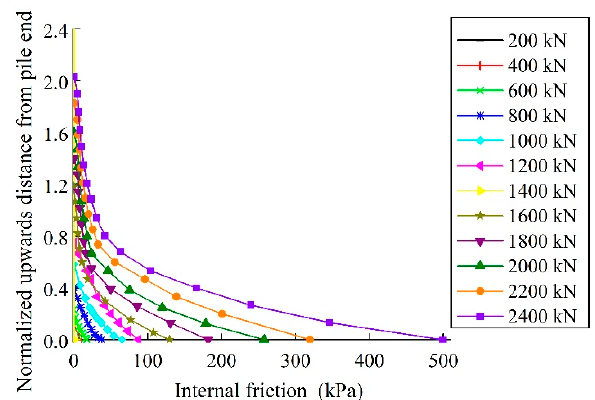
Figure 10. Distribution of internal skin friction under loading.